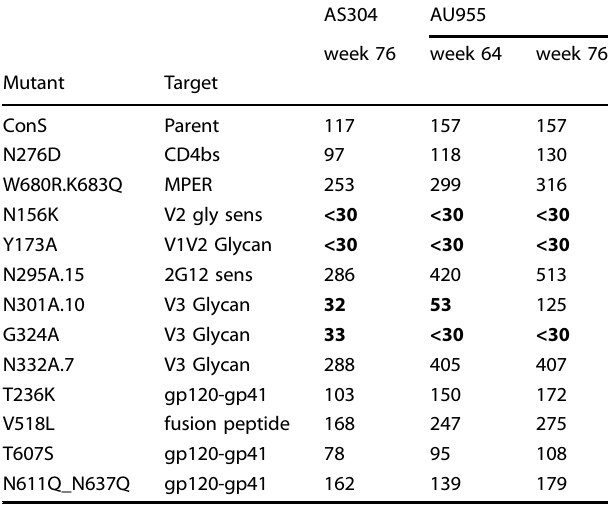
Table 3. Serum neutralization activity against the Consensus tier 1B ConS